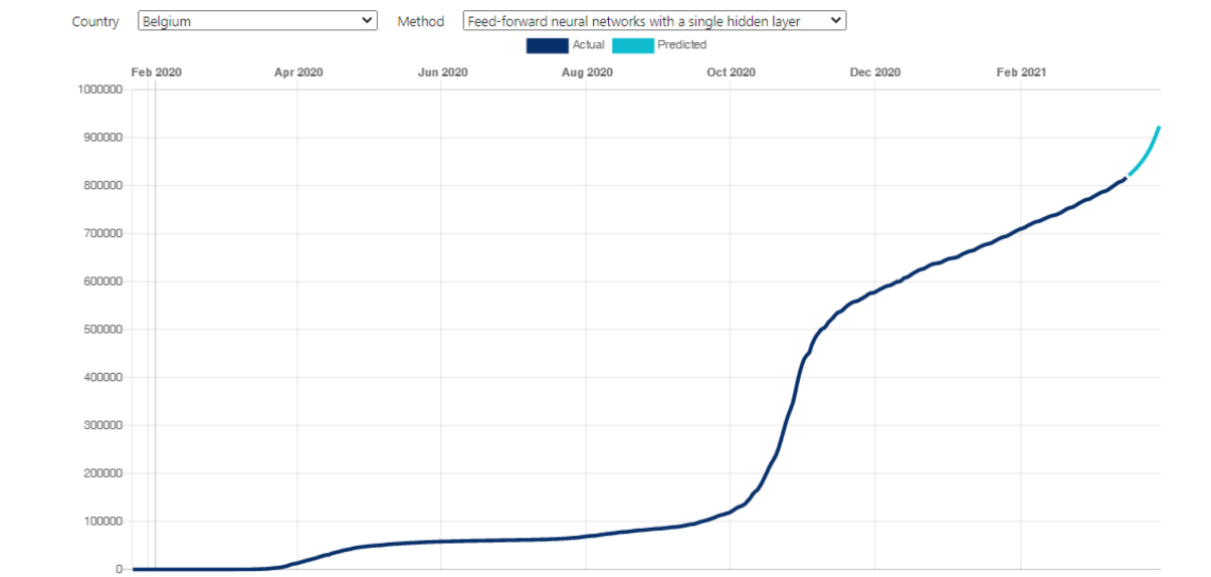
Figure 3. The COVID-19 Pandemic AI System (CPAIS) interface for machine learning prediction models facilitating 14-day COVID-19 forecasting. The plot shows the curve for deep learning modeling of total cumulative confirmed